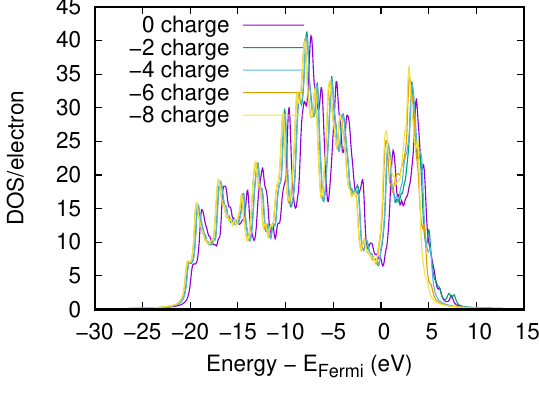
Figure 2. Absorption spectra of a SWCNT when electrons are added to it. Figure 4. DOS for a SWCNT when electrons are added to